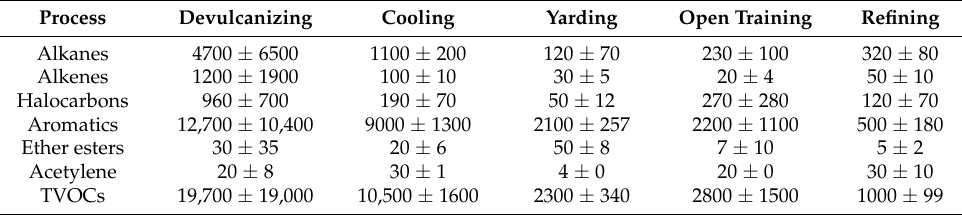
Table 2. Concentration characteristics of VOCs components in each process ( µ g/m 3